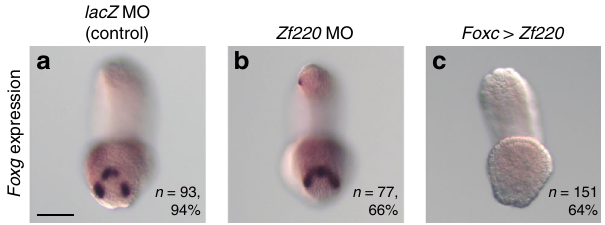
Fig. 6 Zf220 restricts Foxg expression to cells forming palp protrusions. In situ hybridization of Foxg in tailbud embryos introduced with a the lacZ MO, b the Zf220 MO, and c an over/mis-expression construct of Zf220 ( Foxc > Zf220 ). The number of embryos examined and the proportion of embryos that each panel represents are shown within the panels. The scale bar in ( a ) represents 50 μ